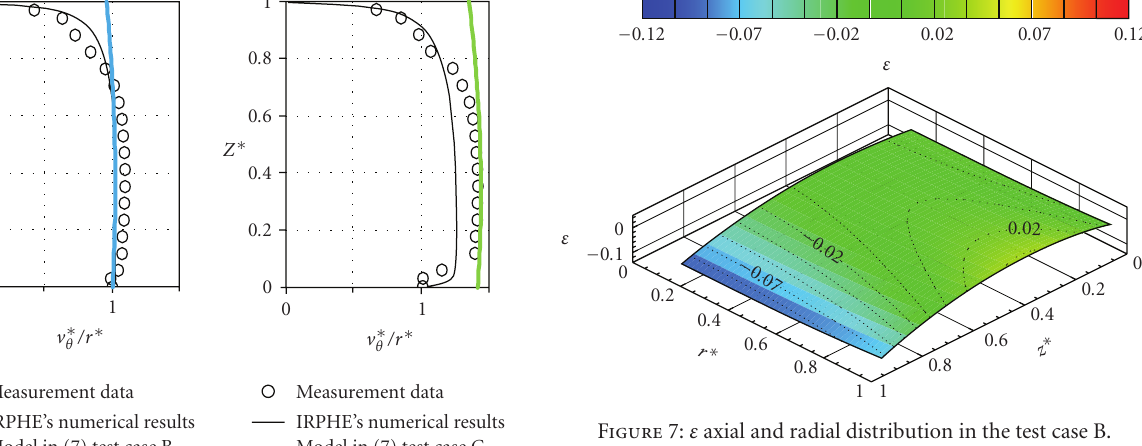
Figure 7: ε axial and radial distribution in the test case B.